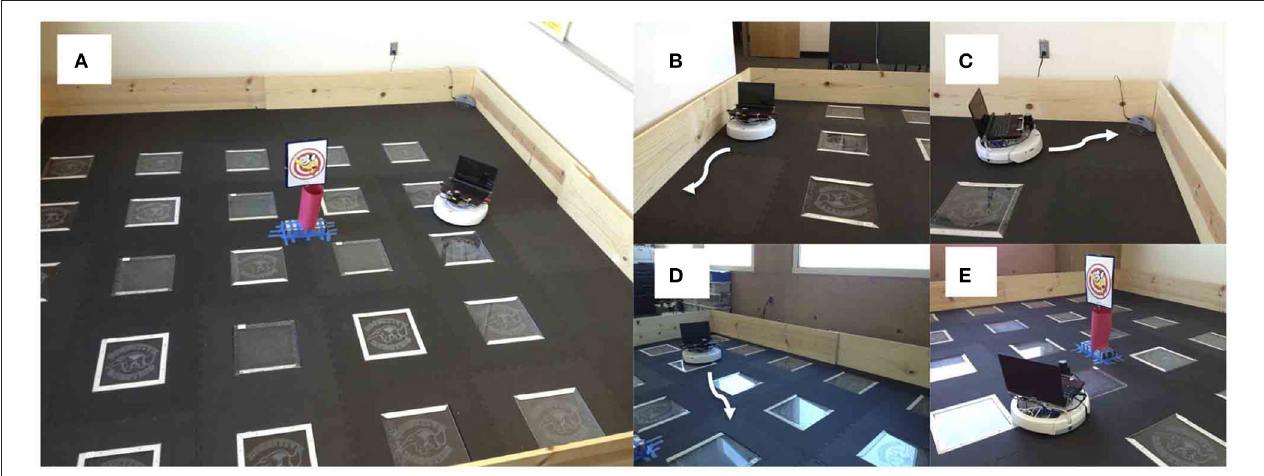
FIGURE 8 | Neurorobotic experimental setup for invigorated and withdrawn behavior. Experiments were run on an iRobot Create. (A) Robot arena. The picture in the middle was a novel object for the robot to explore. (B) Wall follow behavior. (C) Find home behavior. Finding the robot’s docking station. (D) Open field behavior. (E) Explore object behavior. Adapted from Krichmar